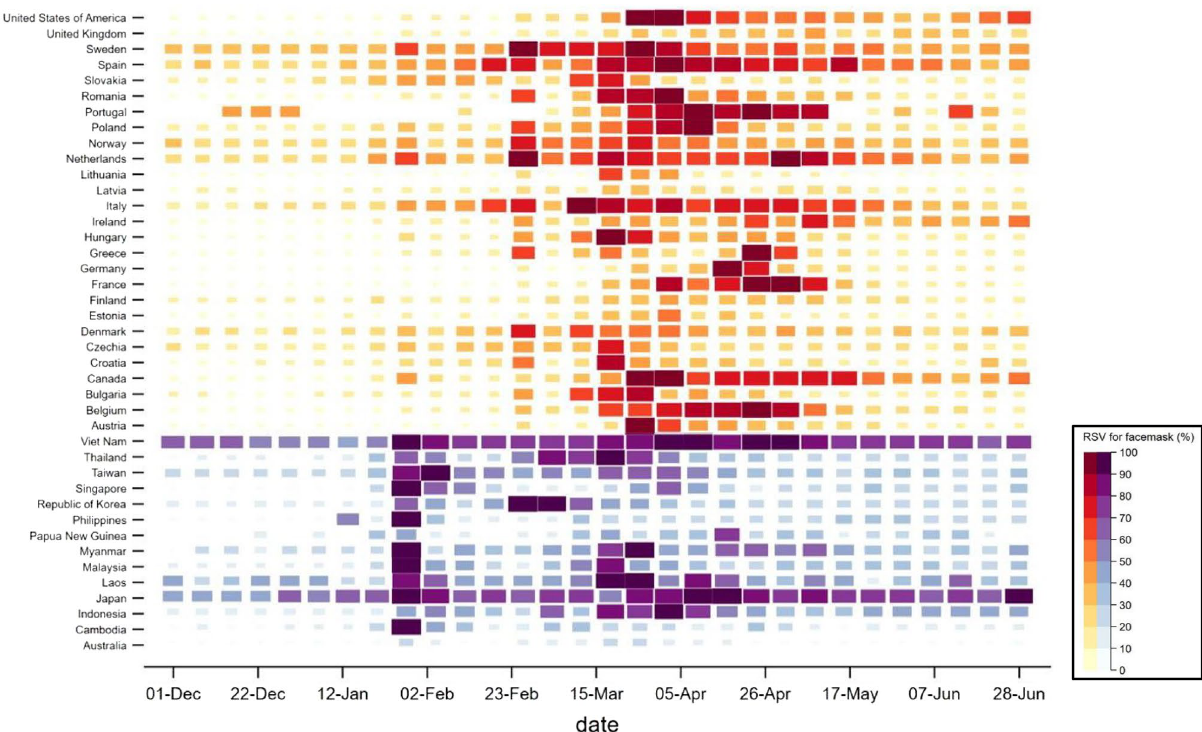
Figure 3. Weekly trend in online searches of “face masks” in Google, expressed in RSV (%), in the West (in red) and in the East (in purple). As extensively explained in the supplementary materials, data from 1st December 2019 to 30th June 2020, accounting for 1-month period of baseline to account for possible confounding for some countries in the East with higher baseline values (ie, Japan and Viet Nam). Additional information on Google Trend RSV can be found in the supplementary